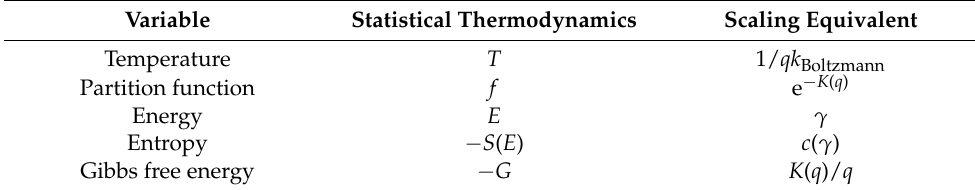
Table 1. Equivalence between statistical thermodynamic and scaling variables. Variable Statistical Thermodynamics Scaling Equivalent